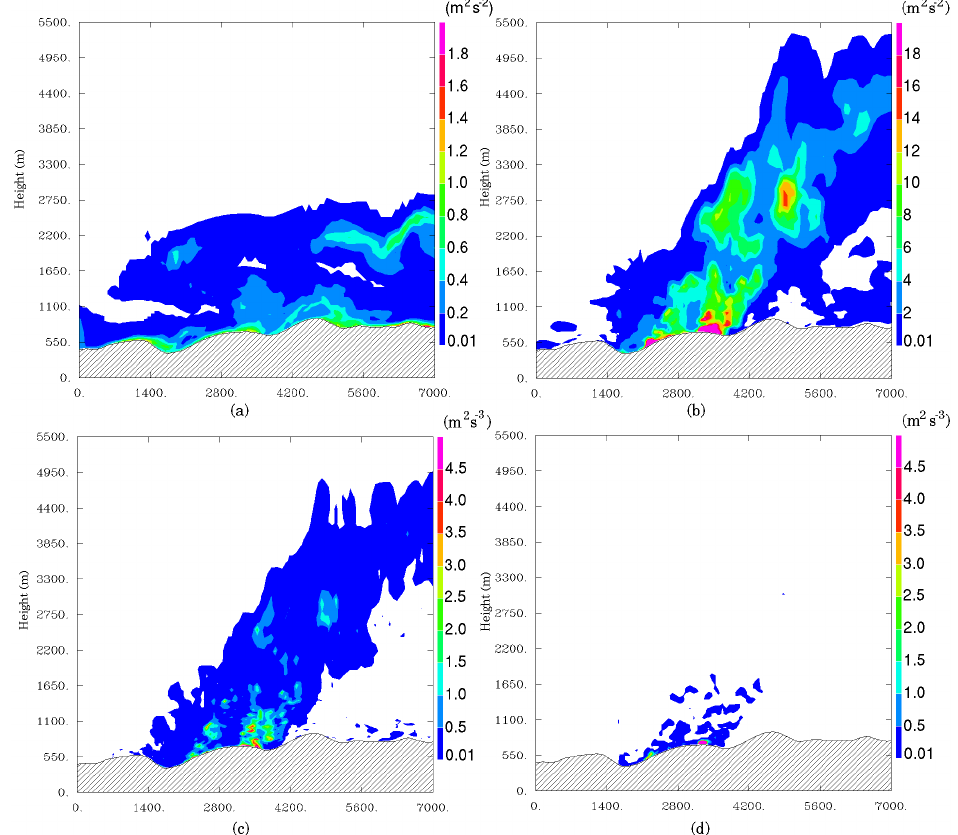
Figure 12. Vertical cross-sections along the direction of propagation (axis(A) in Figure 8a) on 23 July 2009 at 1500 UTC of Turbulent Kinetic Energy (TKE) (in m 2 s − 2 ) for the ( a ) “uncoupled” and ( b ) the difference “coupled minus uncoupled” (with a ratio of 10 between isocontours); ( c ) dynamical production of TKE (in m 2 s − 3 ) and ( d ) thermal production of TKE (in m 2 s − 3 ) for the difference “coupled minus uncoupled”.